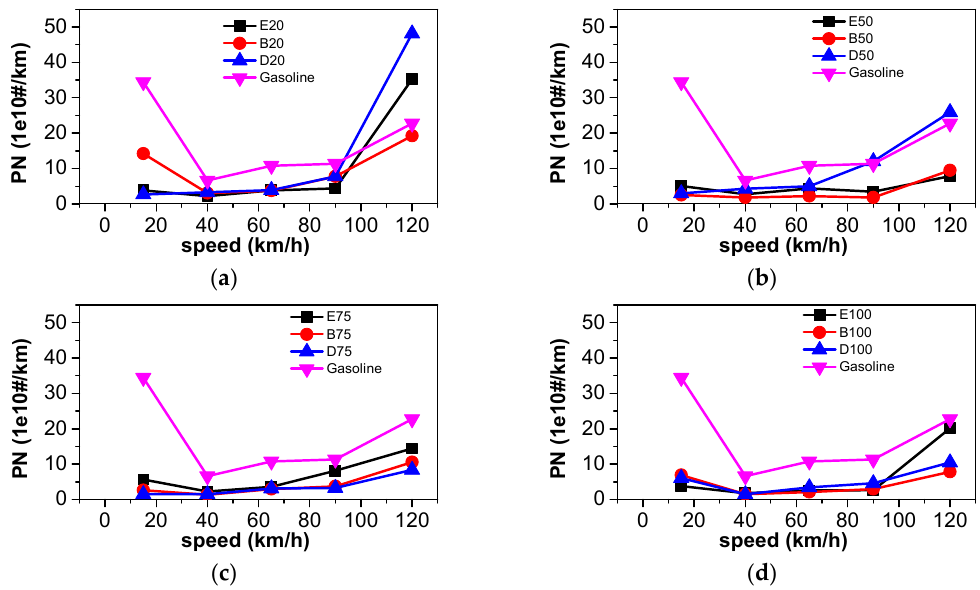
Figure 10. Comparison of particle number (PN) emissions of different fuels at different blending ratios: